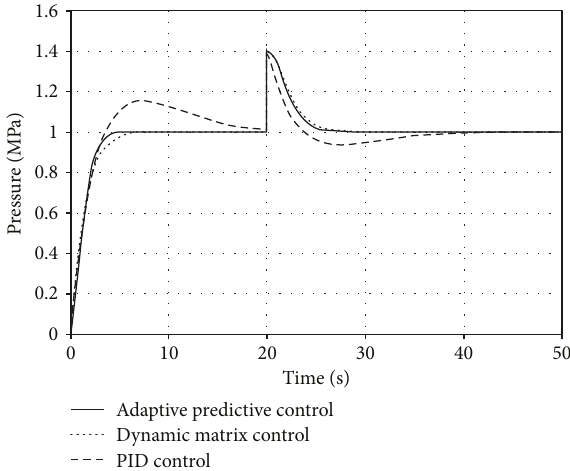
Figure 7: Response curves with di ff erent control systems.